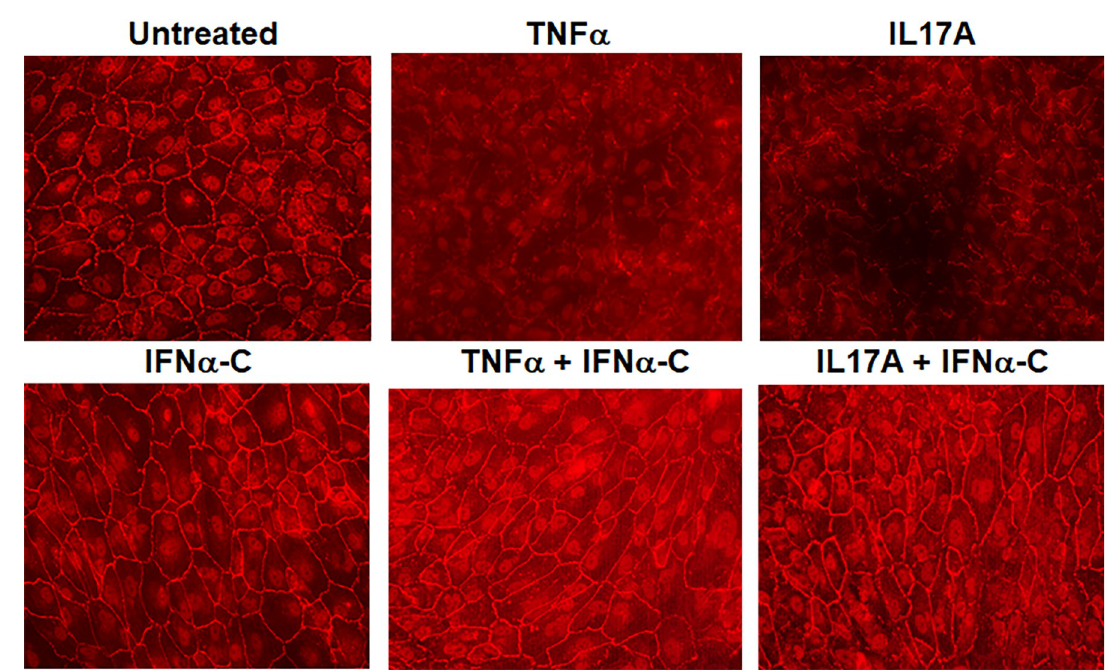
Fig 4. IFN α -C prevented the loss of tight junctions caused by TNF α or IL-17A. ARPE-19 cells grown in 8 well slides in low serum for 4 weeks were pre-treated with IFN α -C (3 μ M) for 4 hr followed by TNF α or IL-17A (both at 50 ng/ml) for 48 hr. These were compared to untreated cells and cell treated with TNF α alone. Cells were fixed, permeabilized and stained with an antibody to ZO-1, followed by staining with Cy3-conjugated secondary antibody, and imaged by fluorescence microscopy at 40x magnification.